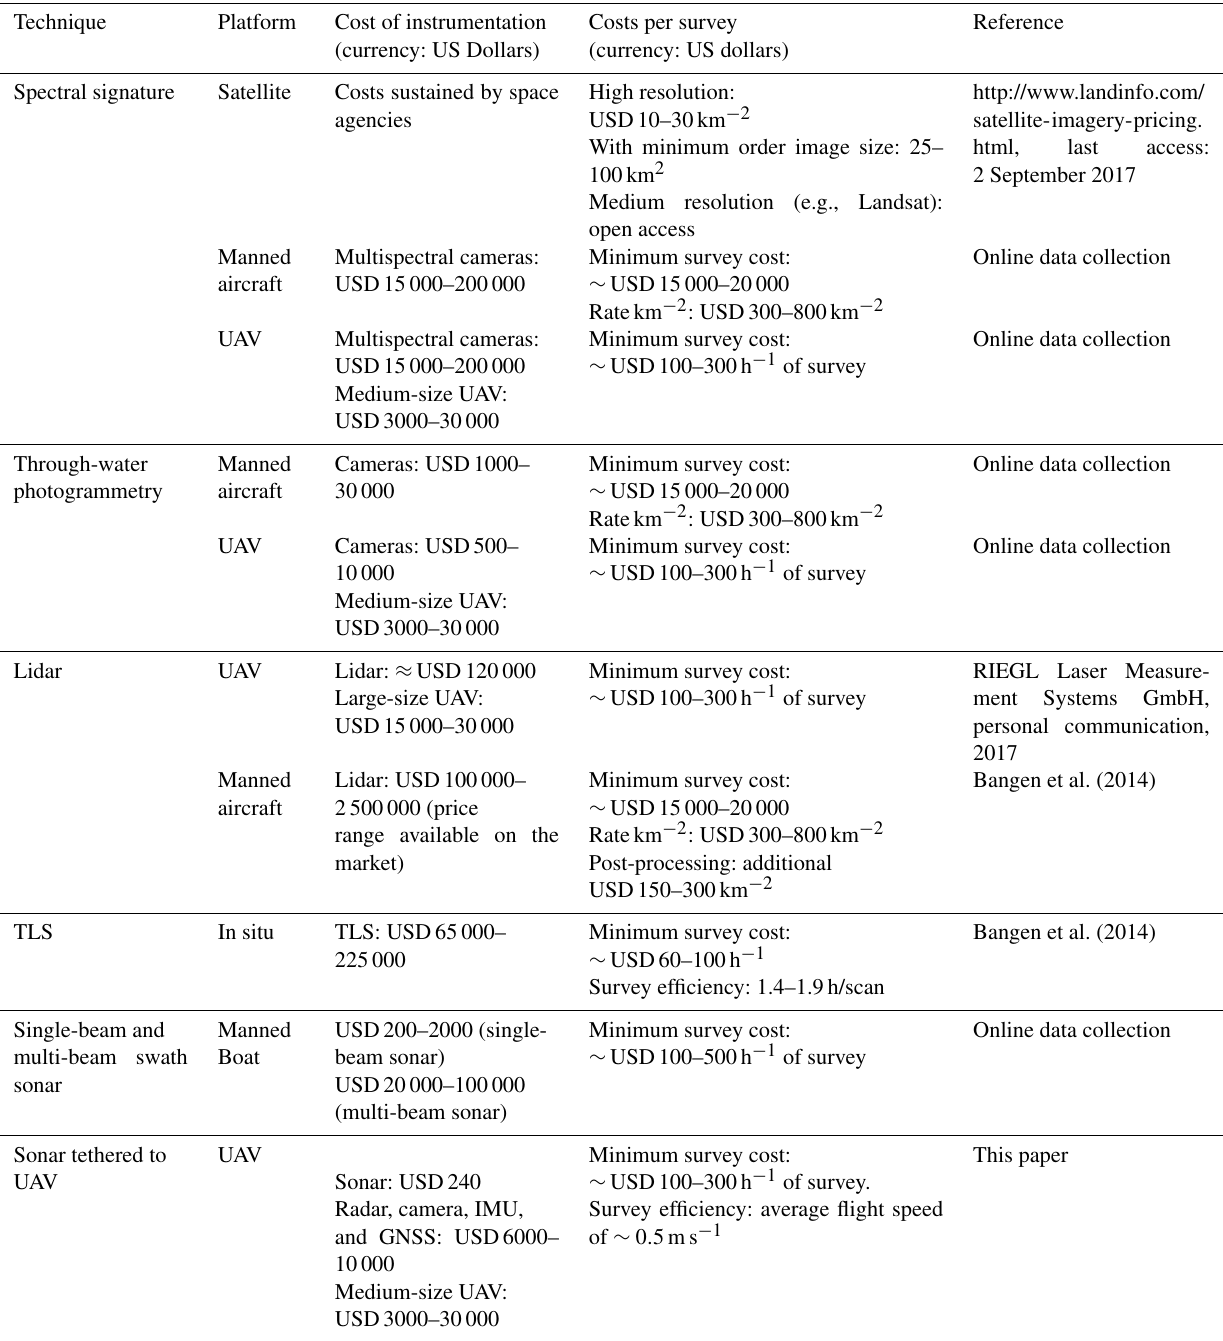
Table B1. Cost comparison for different